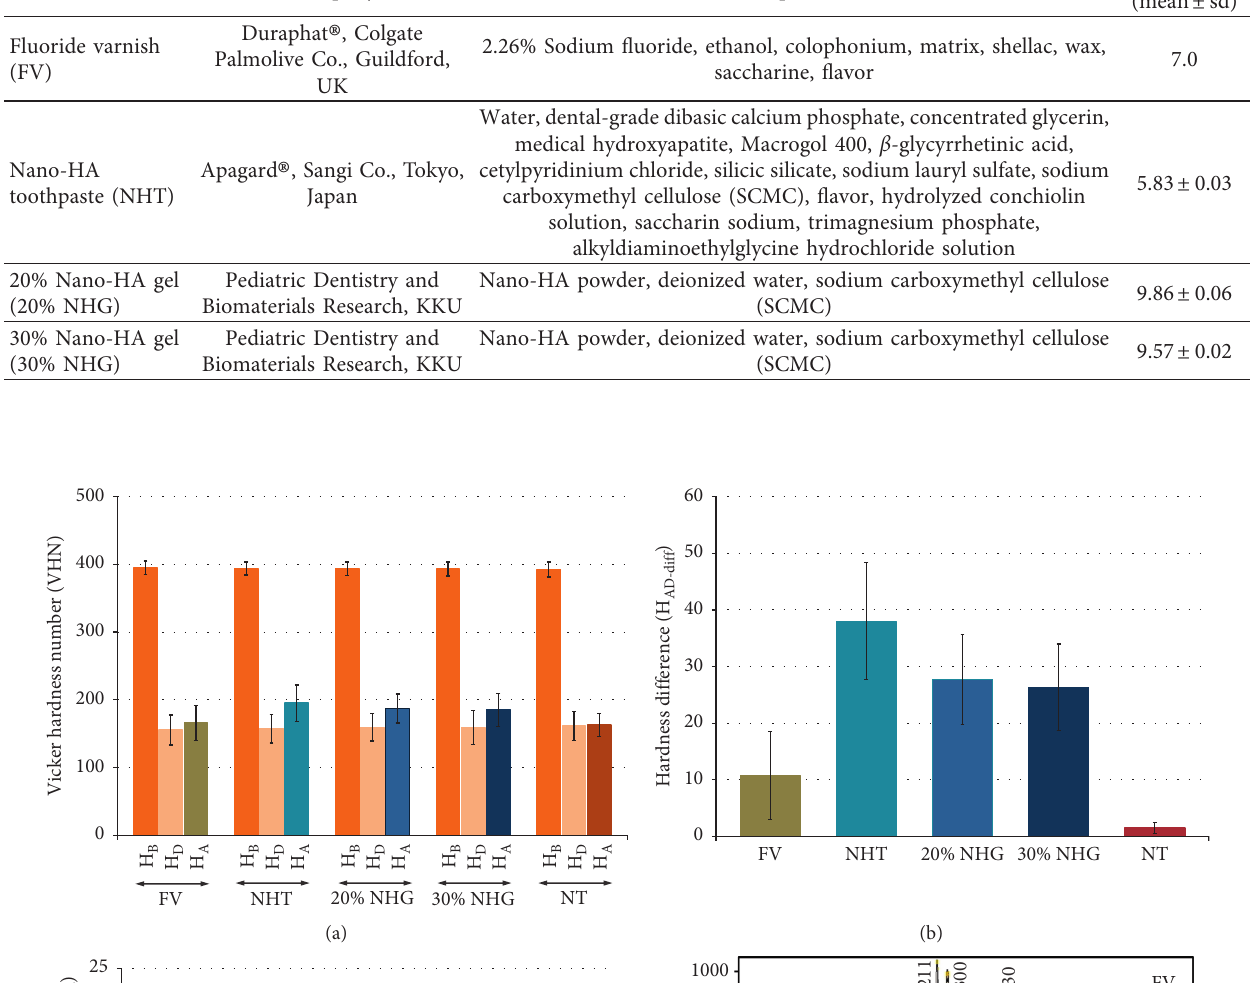
Table 1: Materials, compositions, company, and their average pH values of remineralizing agents evaluated in this present study. Material